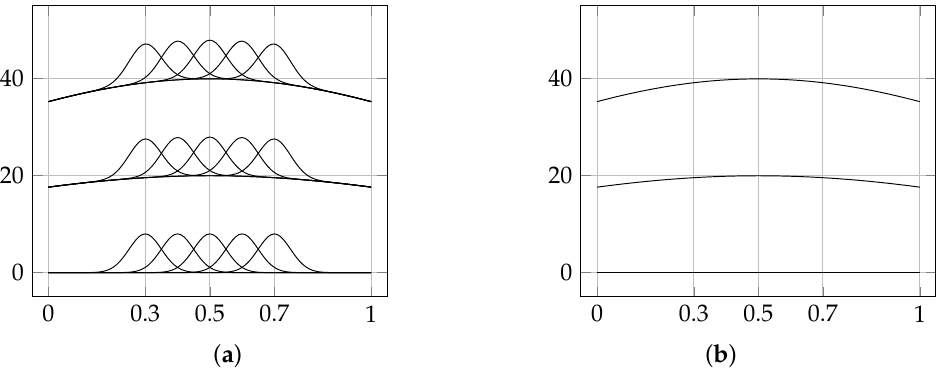
Figure 5. Resulting snapshots for background and foreground model of the analytic test case. ( a ) Resulting snapshots with parameter p d = 1. ( b ) Resulting snapshots with parameter p d =